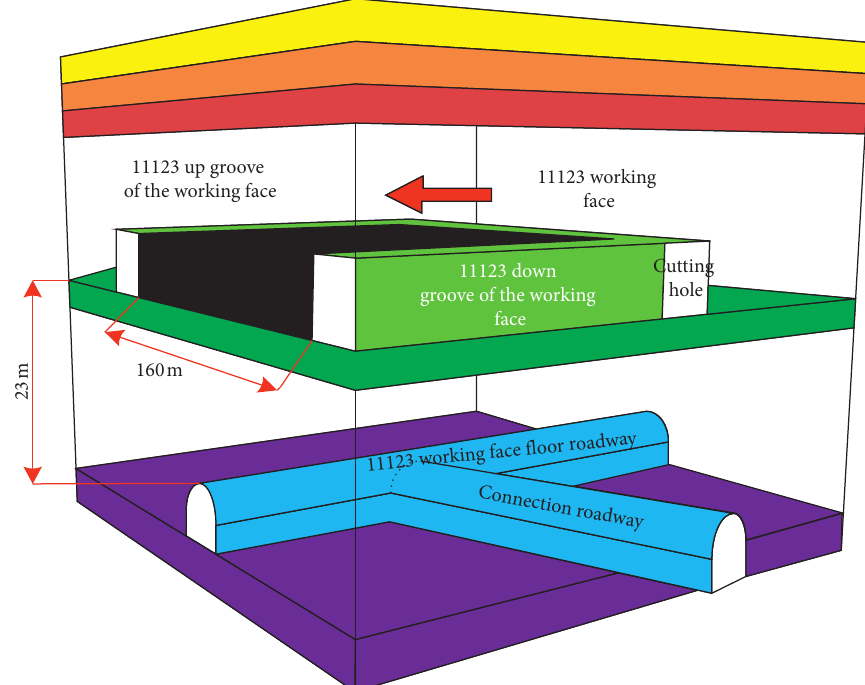
Figure 1: Schematic diagram of the roadway layout of the working face floor.